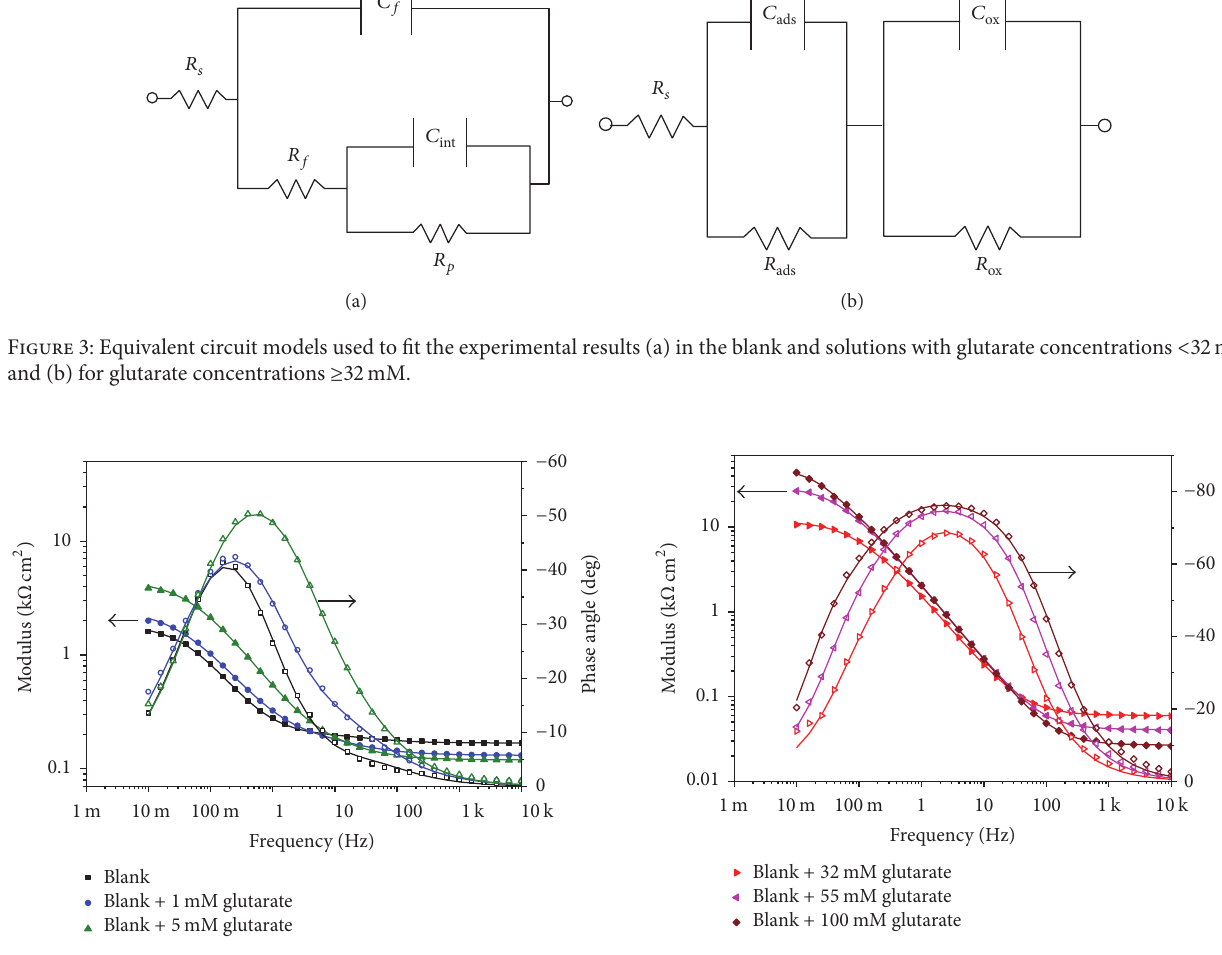
Figure 4: Bode plots of carbon steel in aerated 0.02 M NaCl solution without and with low additions of sodium glutarate (1mM and 5 mM). The solid lines correspond to fitted curves.